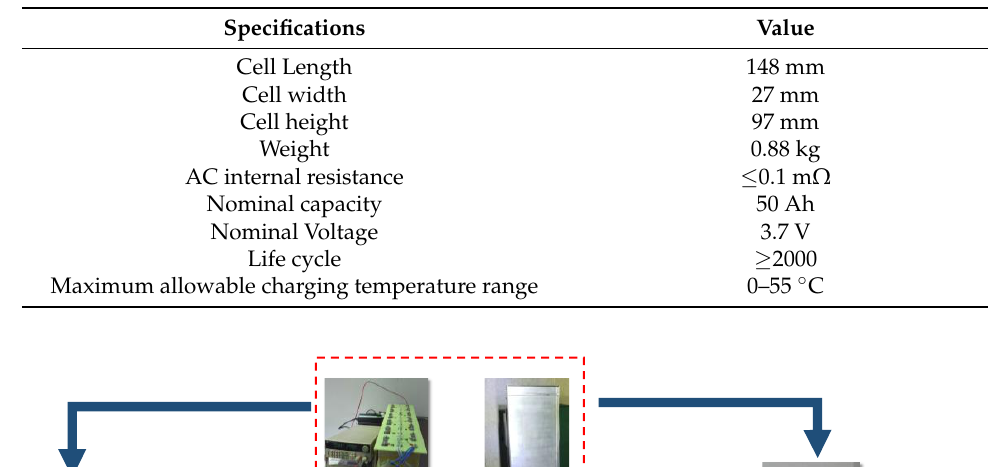
Table 2. Lithium battery parameters.